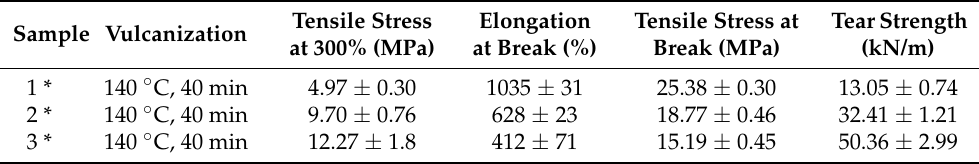
Table 3. Mechanical properties of fiber/NR composites with different fiber contents.